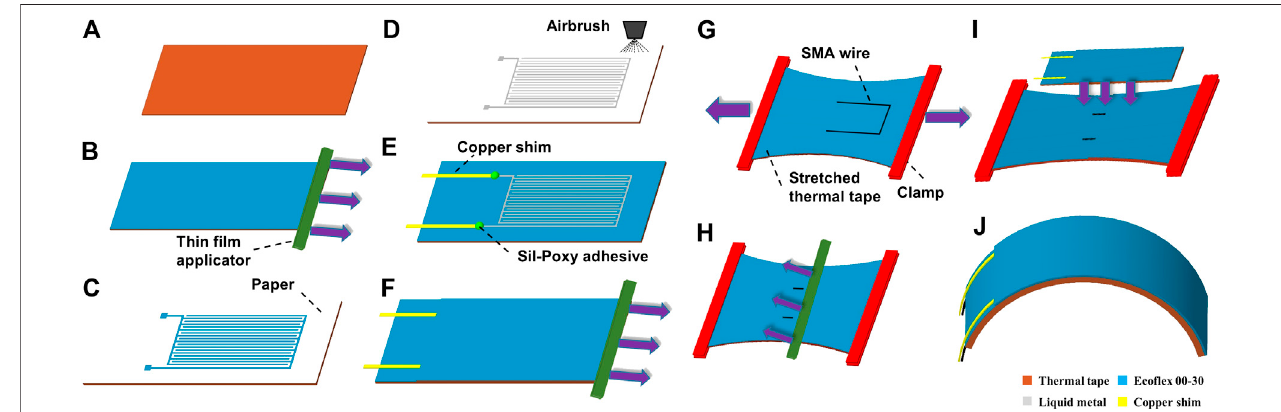
FIGURE 2 | Schematic illustration of the fabrication steps. Left is liquid metal based capacitive strain gague. Right is SMA based actuator. (A) Prepare 55 × 23 × 0.5 mm thermally conductive elastomer. (B) Apply 200 μ m thick silicone (Eco fl ex) layer on top of elastomer. (C) Lay a paper on top of cured Eco fl ex; pattern it usingaCO2laserandremoveunwantedpaper. (D) Sprayliquidmetalonpapermaskandpeelupthepapermask. (E) Putcoppershimateachofthetwoendelectrode tabsandsecurethemusingSil-Poxyadhesive. (F) Apply400 μ mthicksiliconelayeronthesprayedliquidmetal. (G) Stretcha80 × 60 × 0.5 mmthermallyconductive elastomer;apply 100 μ mthick layerofEco fl exon thesurfaceand placeaU-shapedSMA wireon thetopsurface. (H) Applyanother 100 μ m thicklayerofEco fl exon the SMA wire. (I) Bond the curvature sensor to the prestretched layer. (J) Cut out the actuator after it is fully cured.